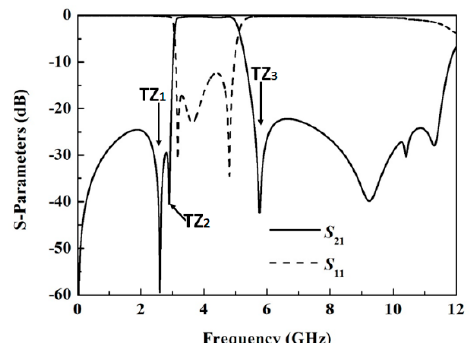
Figure 4. Simulated results of the UWB filter with a wide stopband using EM simulation. L 1 = 3.35 mm, L 2 = 7.1 mm, L s = 13.7 mm, L c = 11.9 mm, W 1 = 3.38mm, W 2 = 0.2 mm, W s = 0.2 mm, G 1 = 0.2 mm, G 2 = 0.15 mm, G 3 = 0.15